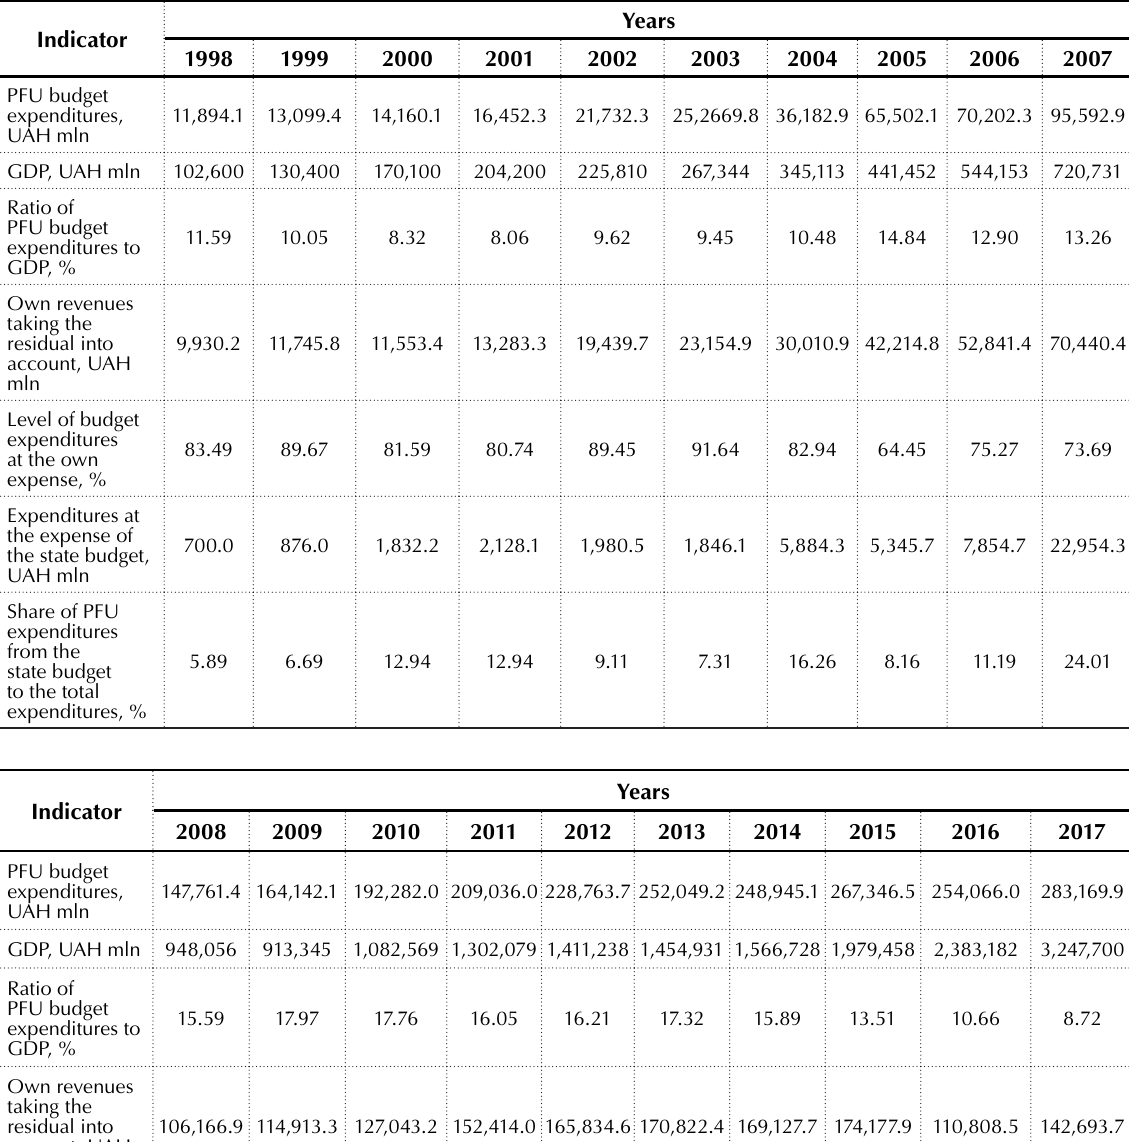
Source: Compiled based on State Statistics Service of Ukraine